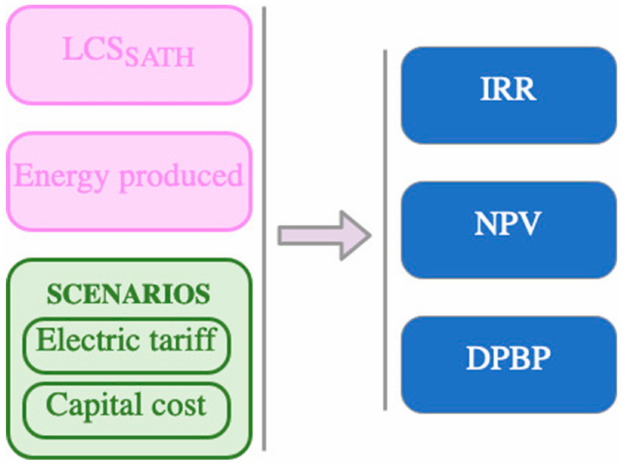
Figure 1. Calculation of the economic parameters.